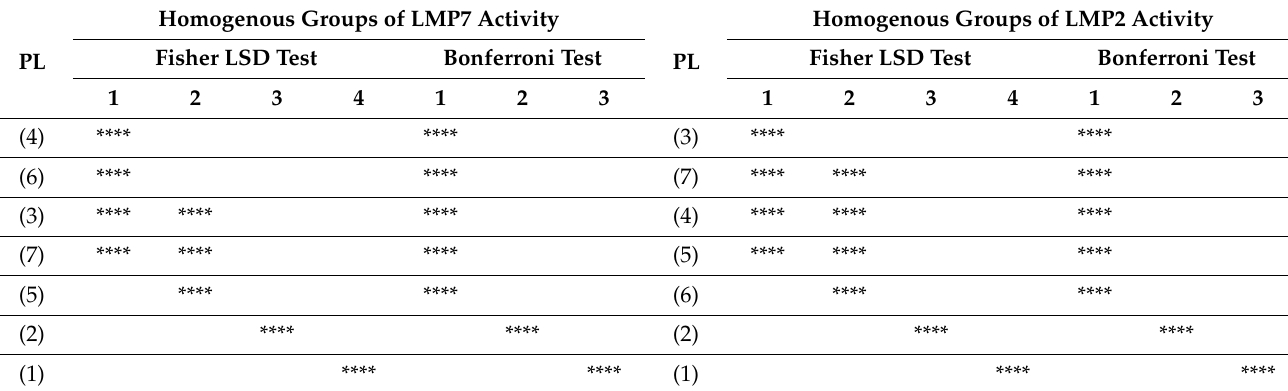
Table 4. Homogeneity of proteasome LMP7 and LMP2 activities in different intestine parts. Homogenous Groups of LMP7 Activity PL